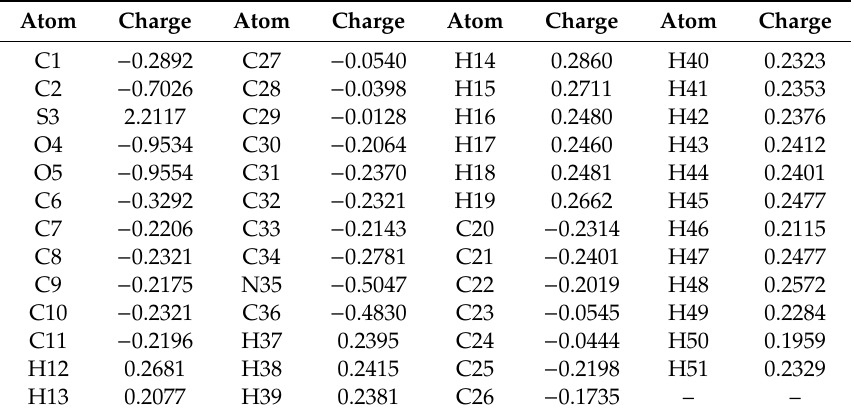
Table 4. The calculated natural charges at atomic sites of aza-Michael product 3 a